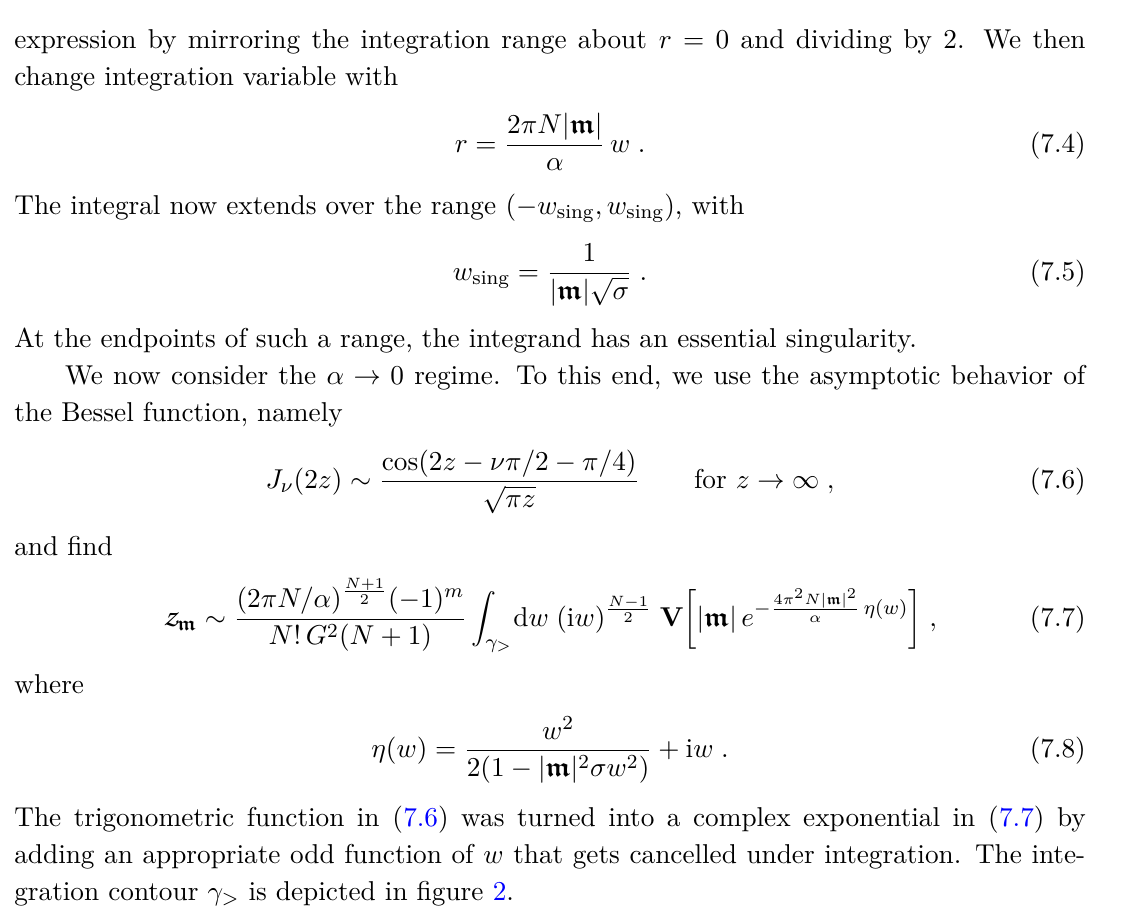
Figure 2 . The integration contour for (7.7). The original integration contour is represented with a dashed red line and runs along the real w -axis. In the α → 0 limit, we deform the contour according to the steepest-descent approximation which prescribes crossing the saddle point at − i ω ? horizontally. The new contour γ > is represented with a solid red